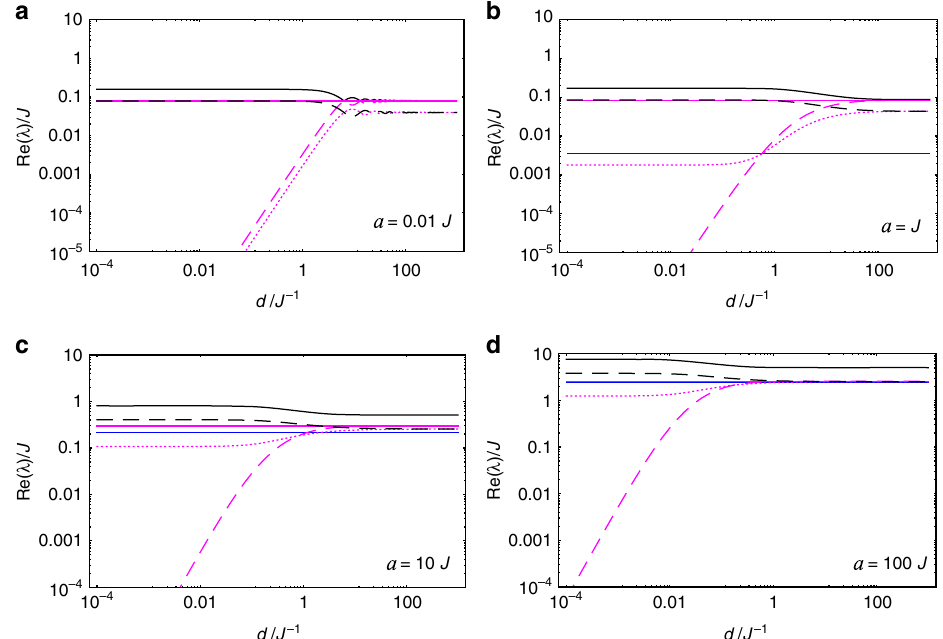
Fig. 5 Spin-separation dependence of relaxation/decoherence rates of the spin system with different proper accelerations. We plot the decay rates (normalized by q 2 and measured by observers at spin-A location), Re( λ k ) (using same style code as in Fig. 2), of the modes ^ ρ k , as functions of the distance d between the spins, for different spin-A accelerations a . Again, note the extreme similarity with Fig.